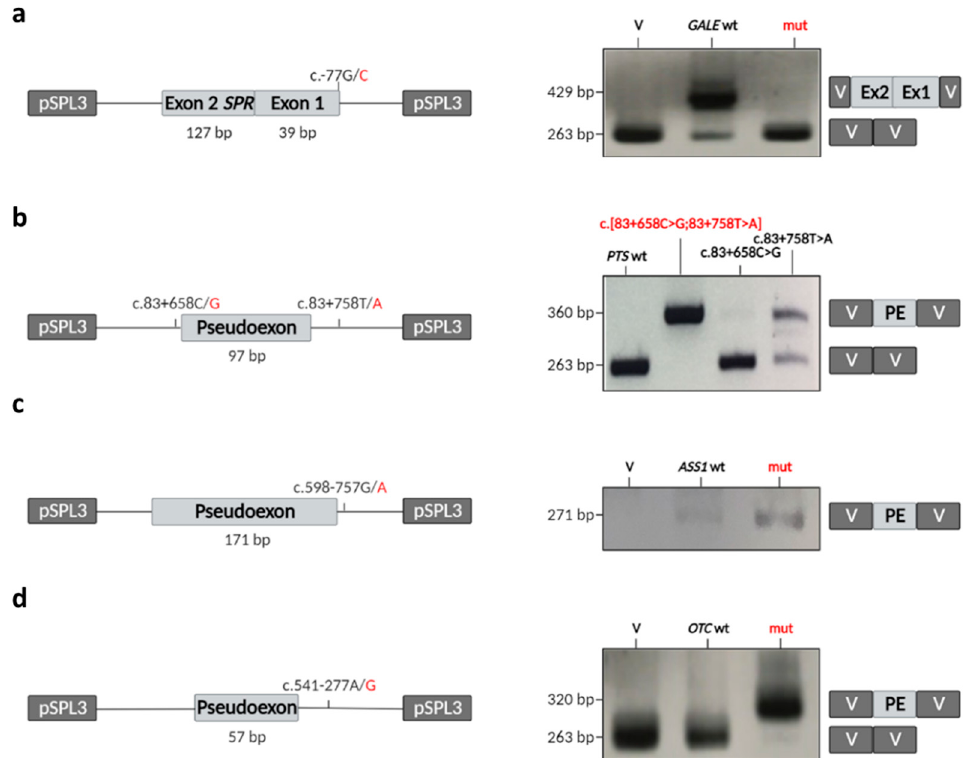
Figure 3. Transcriptional analysis of minigene-derived ( GALE , PTS , ASS1 and OTC ) splicing variants. RT-PCR analysis of ( a ) GALE wt or c.-77G>C, ( b ) PTS wt, c.[83+658C>G;83+758T>A] or each variant on its own, ( c ) ASS1 wt or c.598-757G>A and ( d ) OTC wt or c.541-277A>G. A diagram of the cloned region is shown in the left panel with variant alleles marked in red. The right side of the figure shows the agarose gel electrophoresis results for the amplified fragments, plus the inserted regions. All amplifications were performed with internal vector primers, except for ASS1 , which was amplified with a reverse primer spanning the PE-V junction. V: vector, Ex: exon, PE: pseudo- exon.